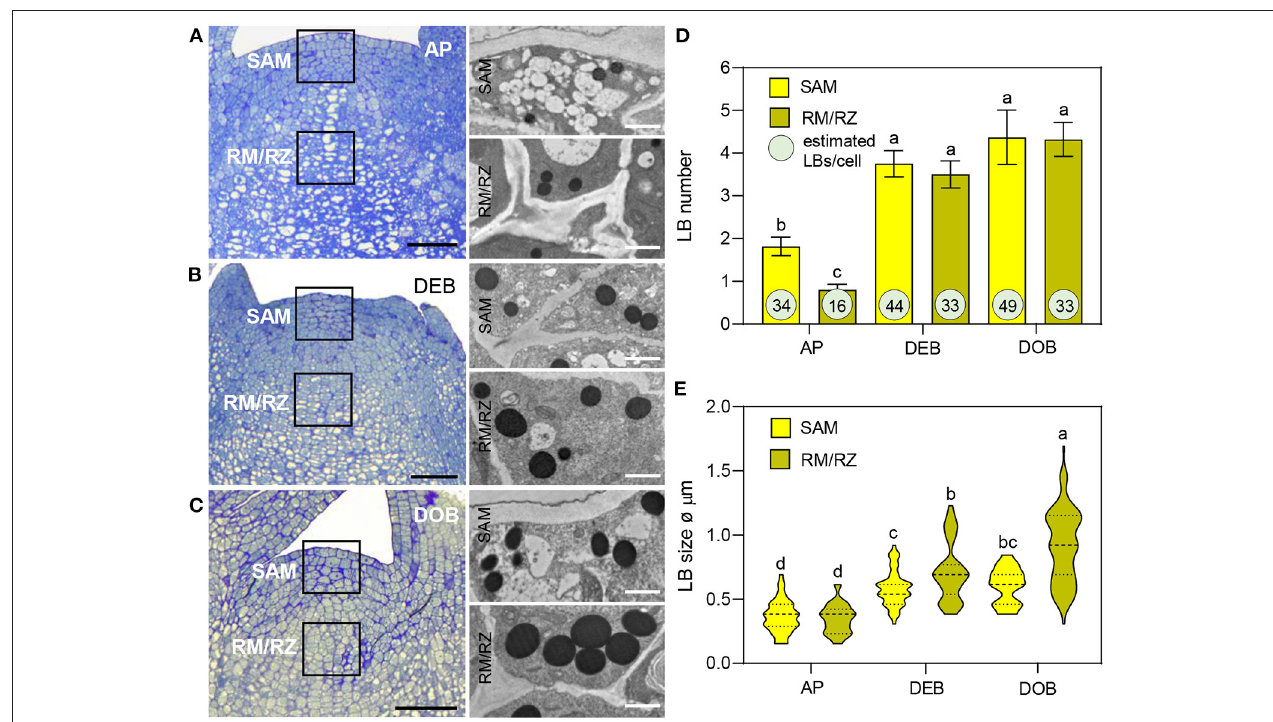
FIGURE 1 | Lipid body (LB) production in the shoot apex of Populus . (A–C) show apices of (A) actively growing plants in long days (APs), (B) in short day-induced developing buds (DEBs) and (C) dormant buds (DOBs). TEM images (A–C) show LBs in the shoot apical meristem (SAM) and the rib meristem/rib zone (RM/RZ) (boxed meristem areas). (D) LB numbers were counted and (E) LB diameters were measured in successive TEM images. Bar diagram (D) shows means ± SD of LB numbers per cell per section. The encircled numbers are calculated LB numbers per cell volume based on average cell sizes, as explained in Supplementary Figure 1 . (E) Violin plots show diameters of LBs including mean-line and quartiles. Different letters indicate statistically significant differences between treatments (one-way ANOVA, Fisher’s post-hoc analysis P < 0.05). Bars are 50 (apices) and 1 µ m